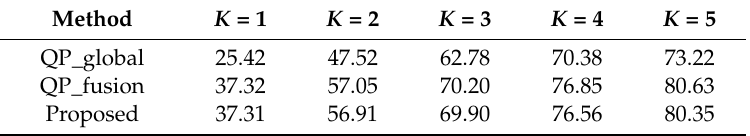
Table 3. Hit rate of TV recommender systems with external user information (%).